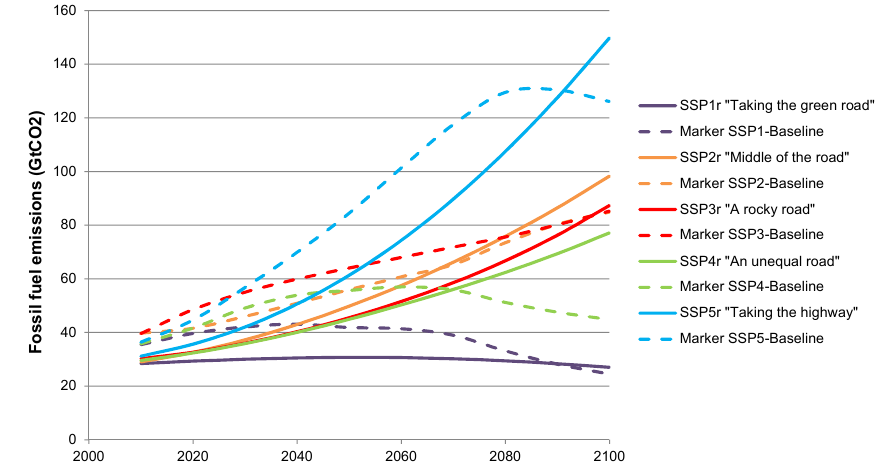
Figure A2. Comparison between CO 2 emissions of the reference scenarios from the climate–economy model used in this paper (full lines) and the total CO 2 emission scenarios presented in Riahi et al. (2017) and available from SSP Database (2015; dashed lines).